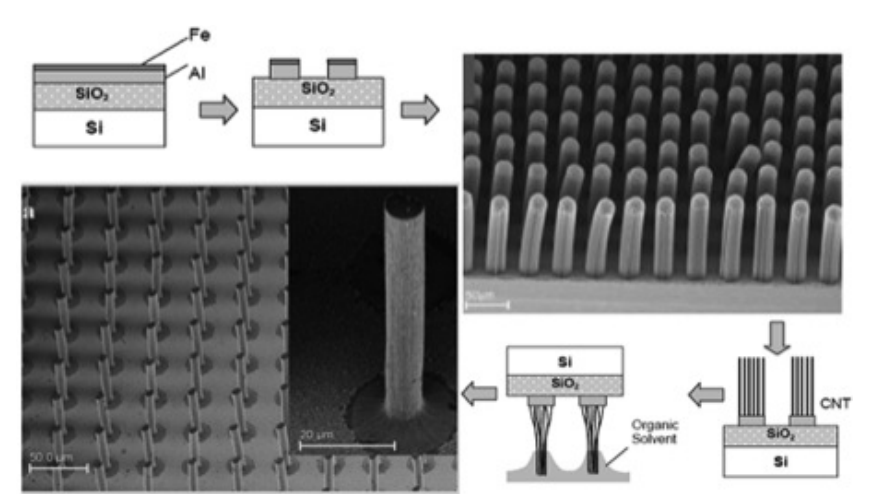
Figure 4. Schematics and SEM images describing capillary coalescence-driven densification using an organic solvent in aligned MWNT PNAs